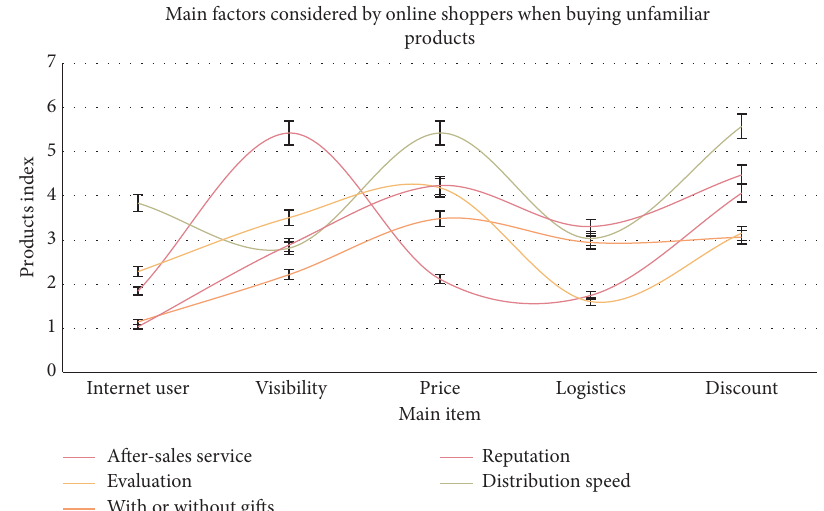
Figure 5: Main factors considered by online shoppers when buying unfamiliar products.